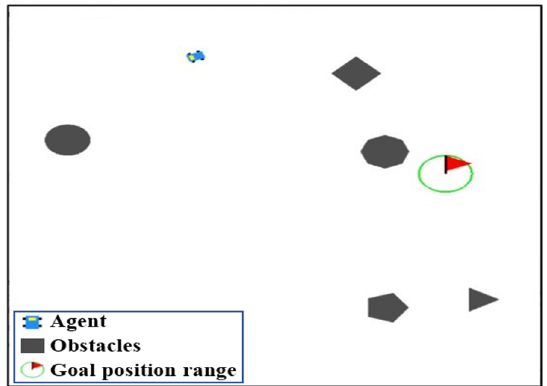
Figure 6. An example of a random scene.